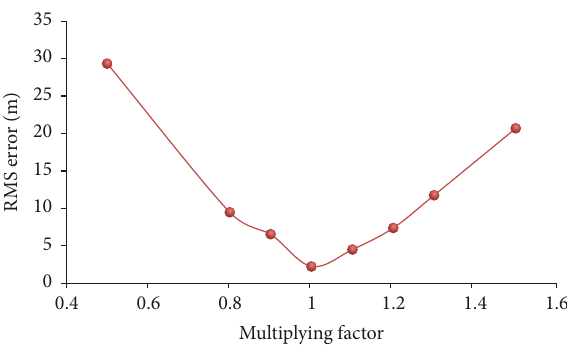
Figure 9: Sensitivity analysis with respect to transmissivity.